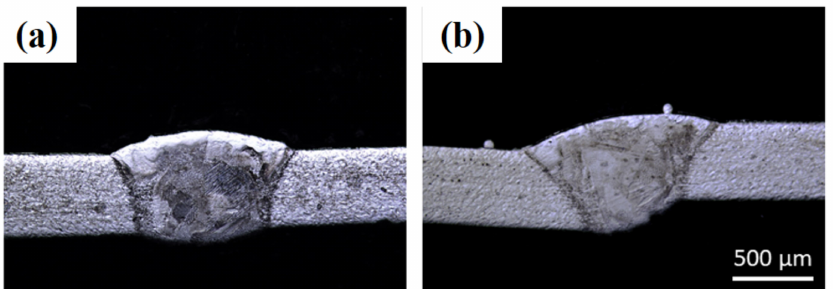
Figure 13. Optical images of 0.4 mm welded plates using Inconel 718 filler material with laser power = 1000 W, laser scanning speed = 2.4 m/min, powder flow rate = 6 g/min, helium gas flow rate = 4 slpm, argon gas flow rate = 10 slpm, and robot tilt angle = 0 ◦ : ( a ) perfect positioning and ( b ) positioning with a height difference of ~100 µ